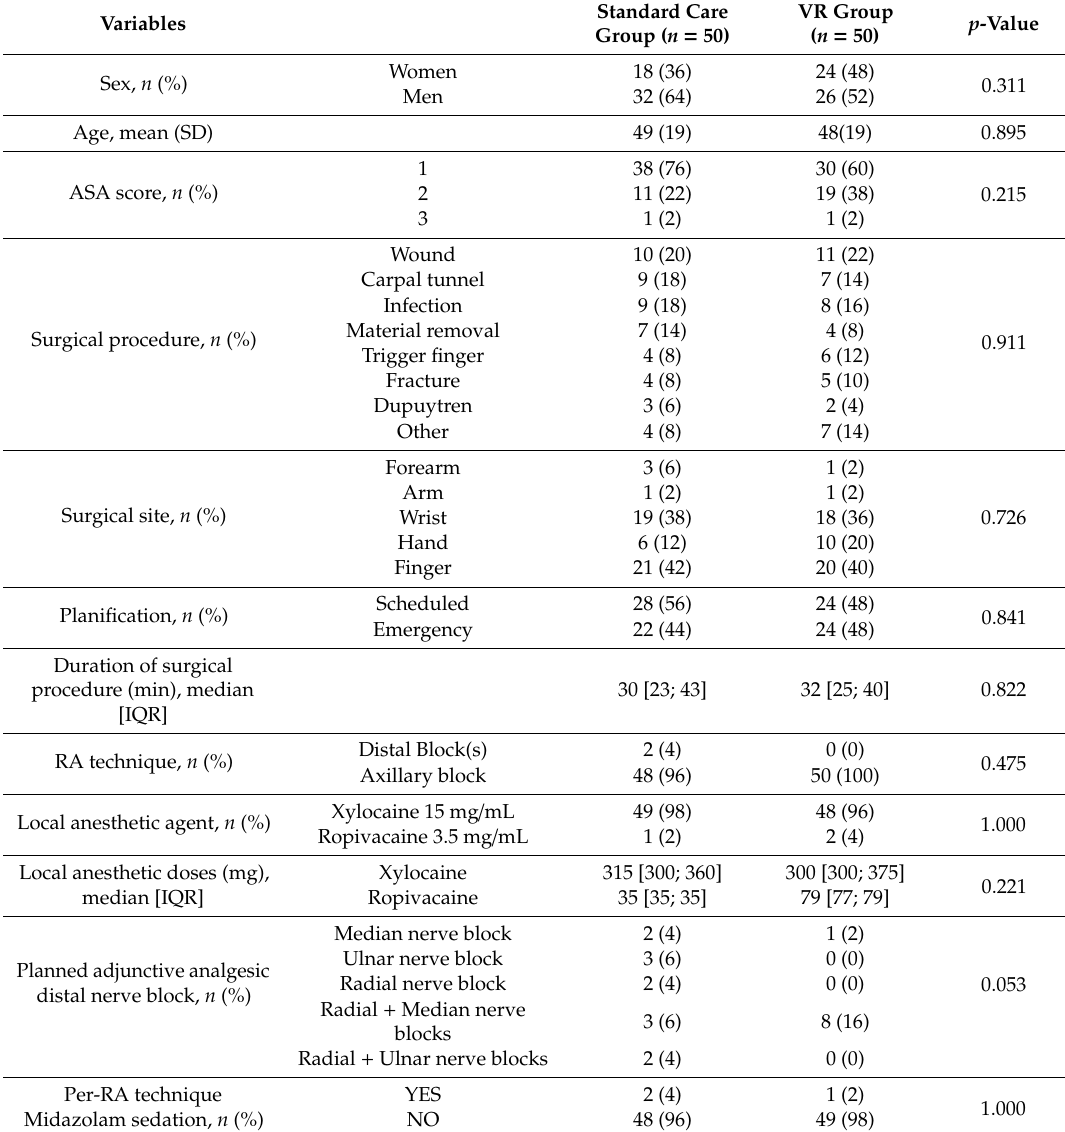
Table 1. Demographic, surgical and anesthetic data of patients operated before (Standard Care group) and after (virtual reality (VR) group) the virtual reality headset became